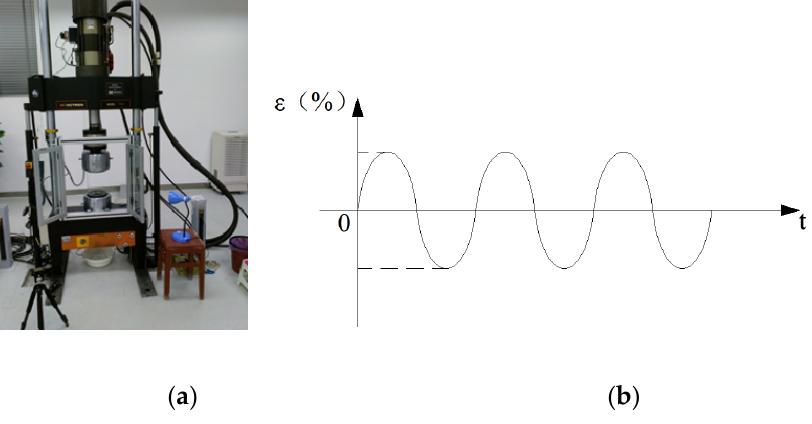
Figure 2. ( a )Test equipment; ( b ) loading history.